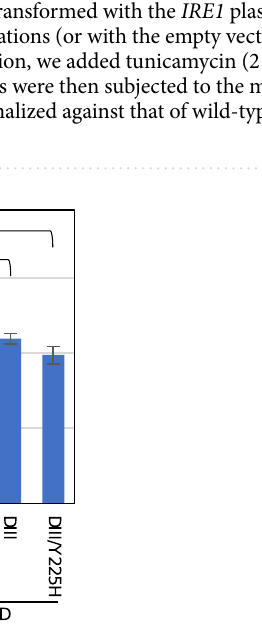
Figure 3. Effect of the Y225H mutation on the physical interaction between the Ire1 luminal domain and unfolded proteins. After denaturation in guanidine HCl solution, luciferase (25 μM) or citrate synthase (50 μM) were 40- (for luciferase) or 100-fold (for citrate synthase) diluted in assay buffer containing MBP-cLD (wild- type: WT) or its mutant versions (1 µM each) or in buffer only, and further incubated at 25 °C for 5 min. The turbidity of the sample mixtures was then measured, normalized against that of the “Buffer only” sample, which is set at 1.0 and presented as